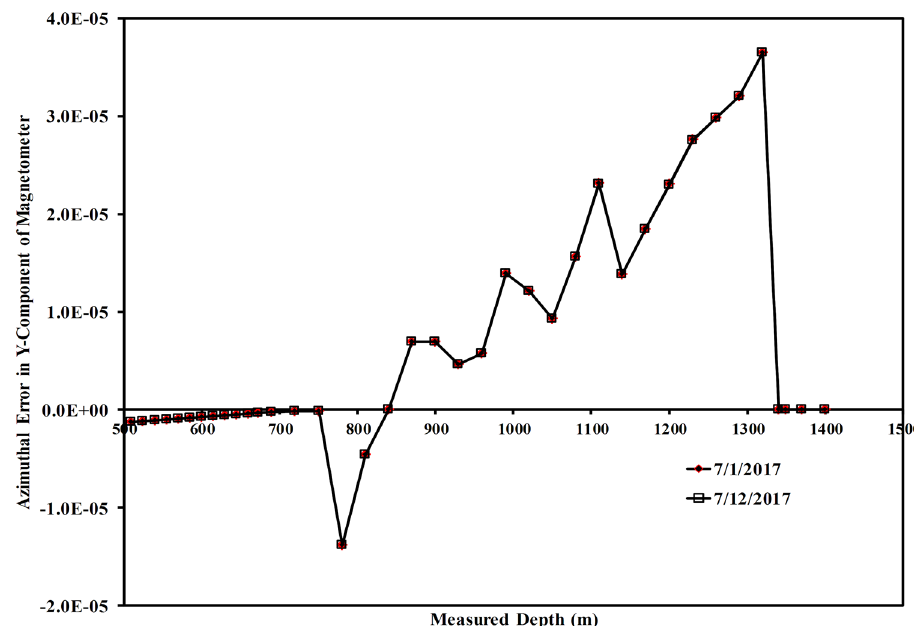
Fig. 9 Error in magnetometer Y -component for Barents